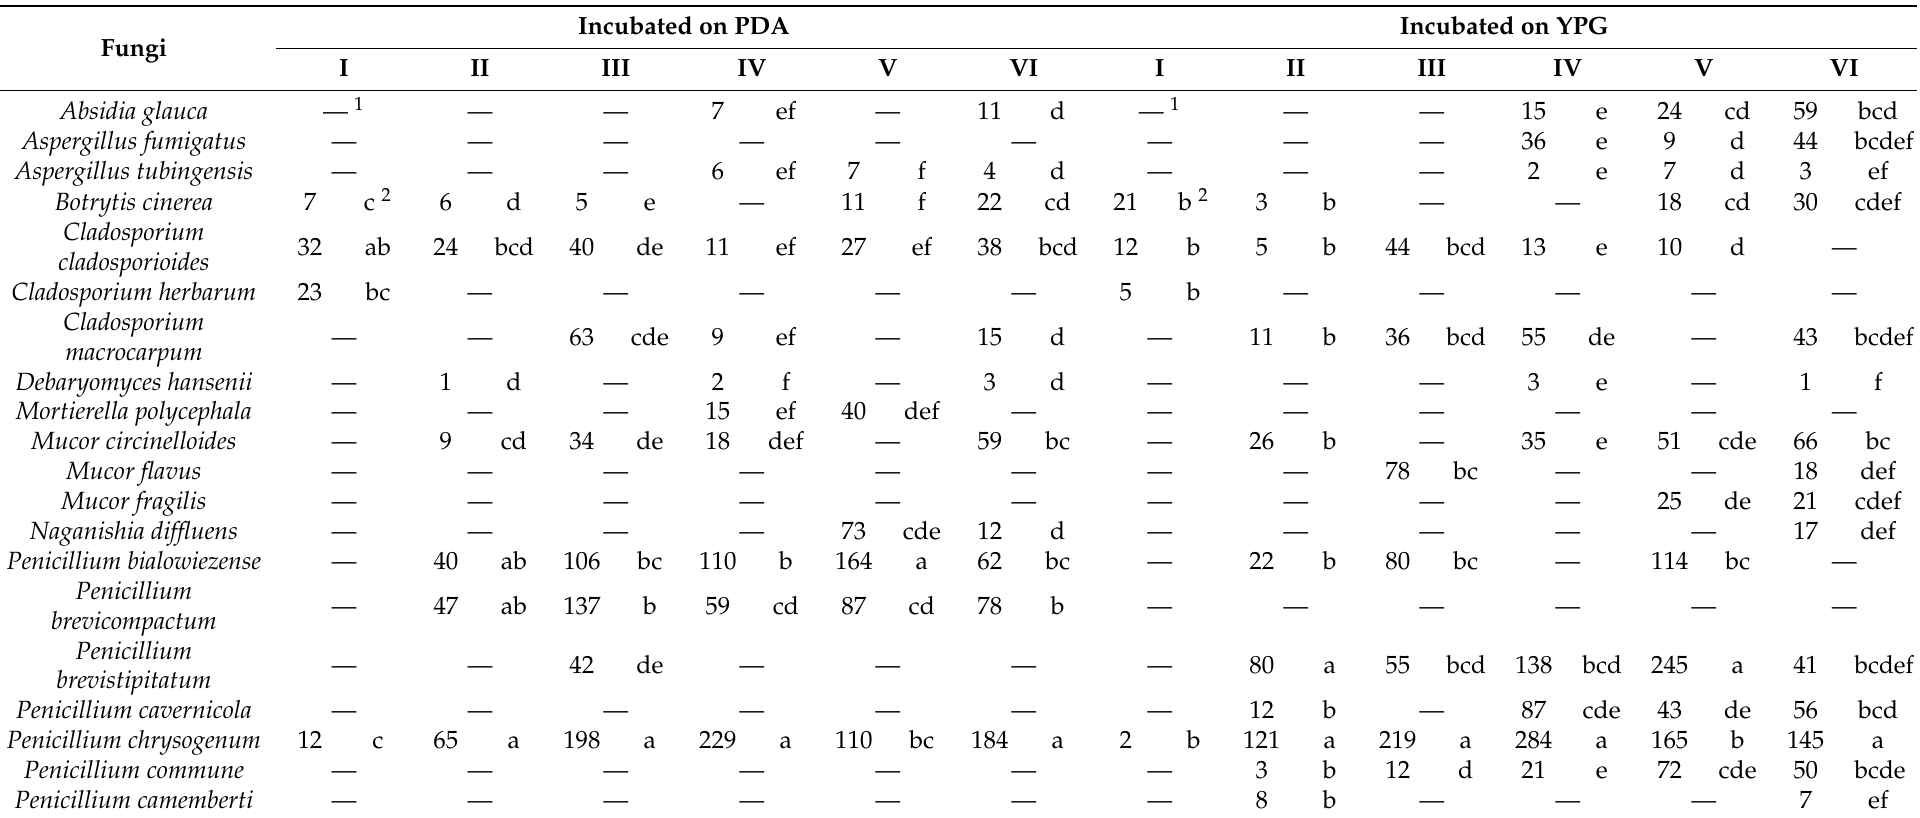
Table A3. The number (CFU m − 3 of air, n = 6) and species composition of airborne fungi cultured at 24 ± 0.5 ◦ C during research in the underground hibernation Nietoperek bat reserve (study site numbers from I to III) and/or present close (study site numbers from IV to VI) to hibernating Myotis myotis . Study site number I was outside the underground object and locations from II to VI inside it. An air sampler was positioned 1.5 m above the level of the floor in study site numbers from I to III, and it was positioned at a distance of 0.7–1 m from clusters of M. myotis in locations from IV to VI: 1 ”—” means not detected. 2 Statistical analysis was performed only for fungal species that were detected in a given study site. For each location, the number of fungal spores followed by the same letter are not statistically different, and others are (Tukey’s HSD test, α ≤ 0.05). Letters indicate the differences between fungal species in a given location; they refer to means in the columns. All analyses were carried out separately for PDA and